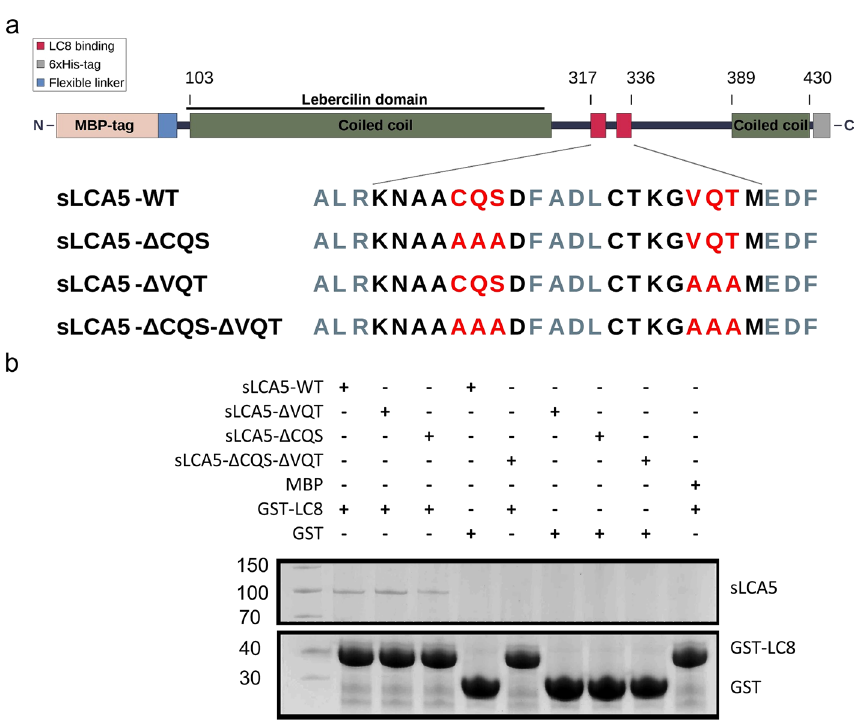
Figure 3. The scheme of the LCA5 recombinant protein constructs and GST pull-down assay. ( a ) Wild-type and mutant constructs with alanine mutations in the core triplets of the LC8 binding regions. An N-terminal MBP tag, connected with a flexible linker region, was introduced to maintain the solubility of the construct. ( b ) In vitro GST pull-down of LC8 and sLCA5 with the mutation analysis of LCA5 binding motifs. The wild type and both of the single binding motif-mutant sLCA5 forms can bind LC8, whereas the introduction of mutations in both putative binding motifs was able to hinder the interaction (see the original gel in Supplementary Fig.